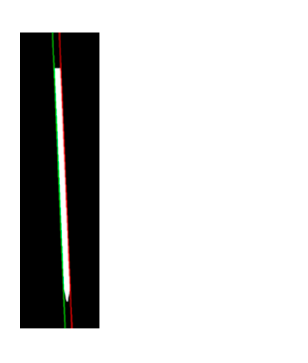
Figure 12. Least square method-based line fitting image of the cutting blade for accurate thickness measurement.